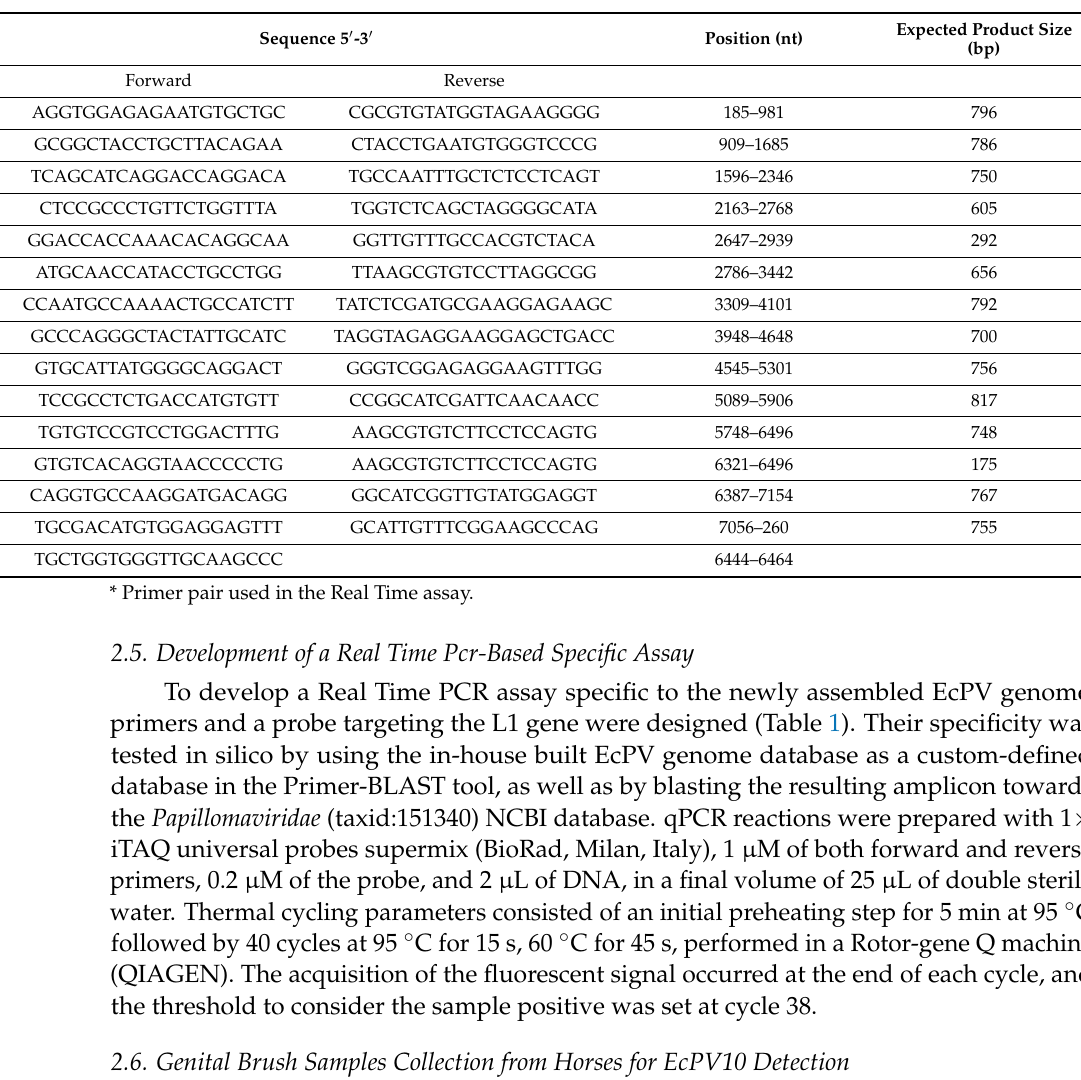
Table 1. Genome walking primers used to verify the reconstructed viral